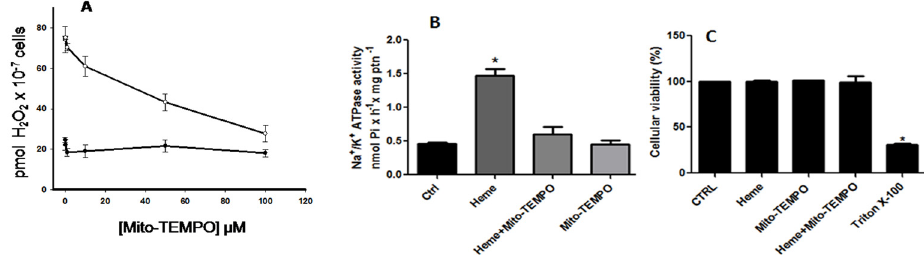
Fig 11. Effect of Mito-TEMPO on the production of hydrogen peroxide by L . amazonensis and on the Na + /K + ATPase activity of the parasite. Living parasites were incubated for 20 min in the reaction medium, with the addition of increasing concentrations of Mito-TEMPO in the presence (white circles) or absence (black circles) of 2.5 μ M heme, as indicated on the abscissa (A). The intact cells were incubated with 100 μ M Mito-TEMPO, in the presence or absence of 2.5 μ M of heme, as indicated on the abscissa, for 20 min. Na + /K + ATPase activity (B) and Cellular viability (C) were determinated. The values represent the mean ± standard error of at least three independent experiments. * Statistically significant when compared to cells incubated with 2.5 μ M of heme without Mito-TEMPO (n = 3, P < 0.05).